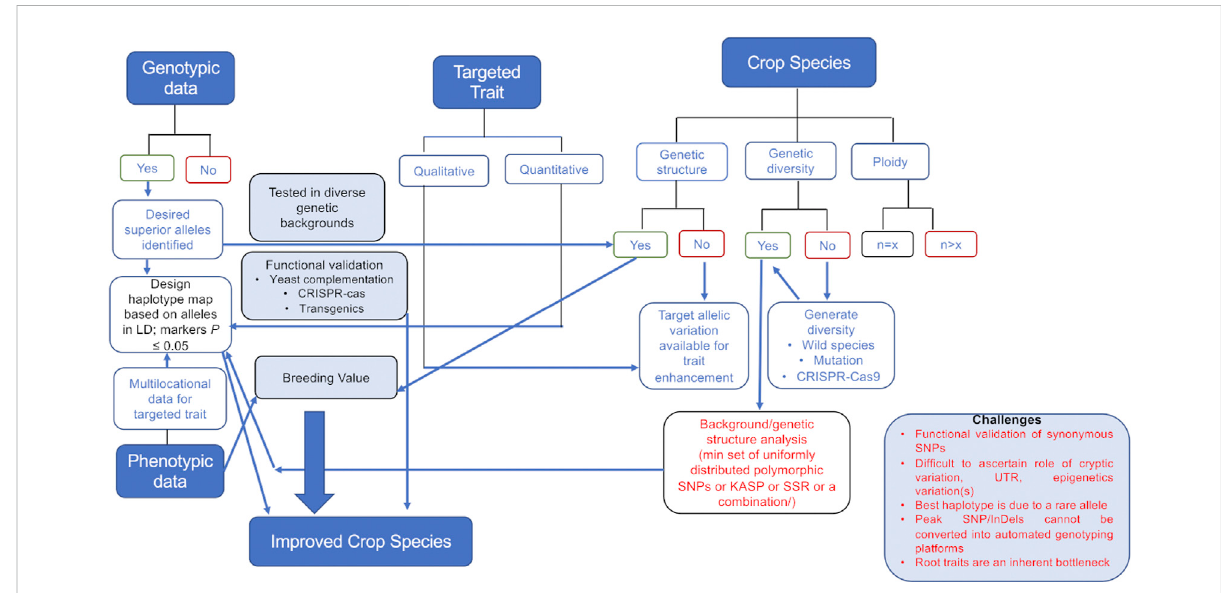
FIGURE 1 Decision-makingtreeinvolvedinusinggenomicsdataforcropimprovement.Genotypicdatawillleadtoselectionofsigni fi cantmarker(s)inthe desired haplotype. The selection of a marker and haplotype will depend on the genetic structure, diversity available in the cultivated gene pool, and ploidy of the crop. Selected marker haplotypes along with the breeding value estimation of a particular genotype would help achieve genetic gains forthetrait ofinterest. Thechallenges (mentionedinthebox)ingenerating thedata(root traits)andutilizingthevariation (crypticvariation,rare alleles, synonymous SNPs, etc.) that still exists are also